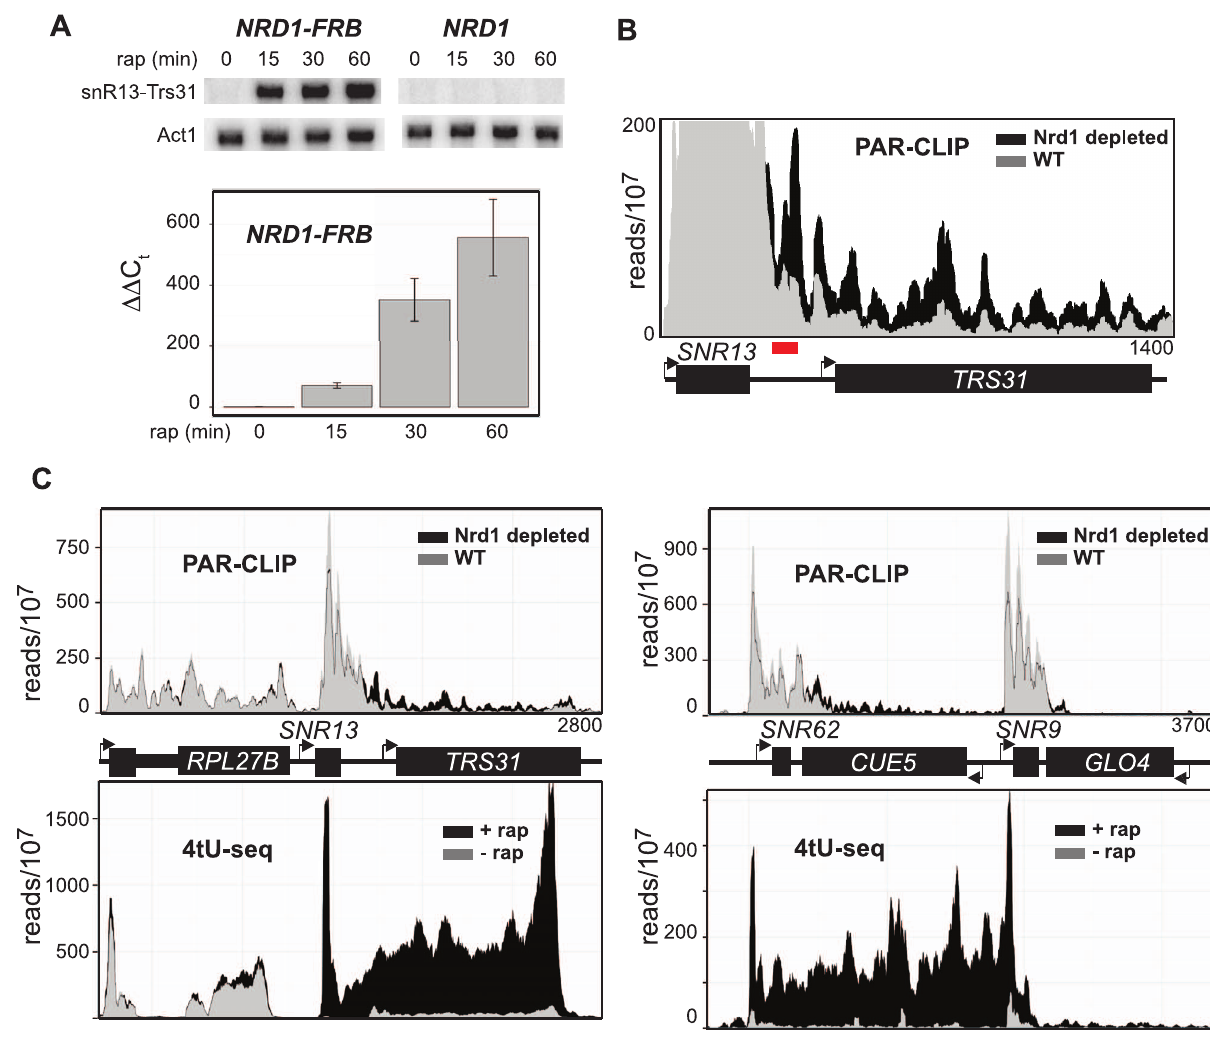
Figure 5. Nrd1 increases the stability of the readthrough transcripts. A. Northern blot and qPCR at different times after addition of rap using the amplicon highlighted in red. B. Histograms representing normalized reads with Nrd1 (grey) and without Nrd1 (black) at the given genomic locations. The Y-axis has been changed to emphasize the differences between treatment with (black) and without rap (grey) for the SNR13-TRS31 locus. C. Similar to A but Schultz et. al. [65] 4tU-seq data is also represented in as a histogram below each graph for the same region of the genome with Nrd1 (grey) and without Nrd1 (black).